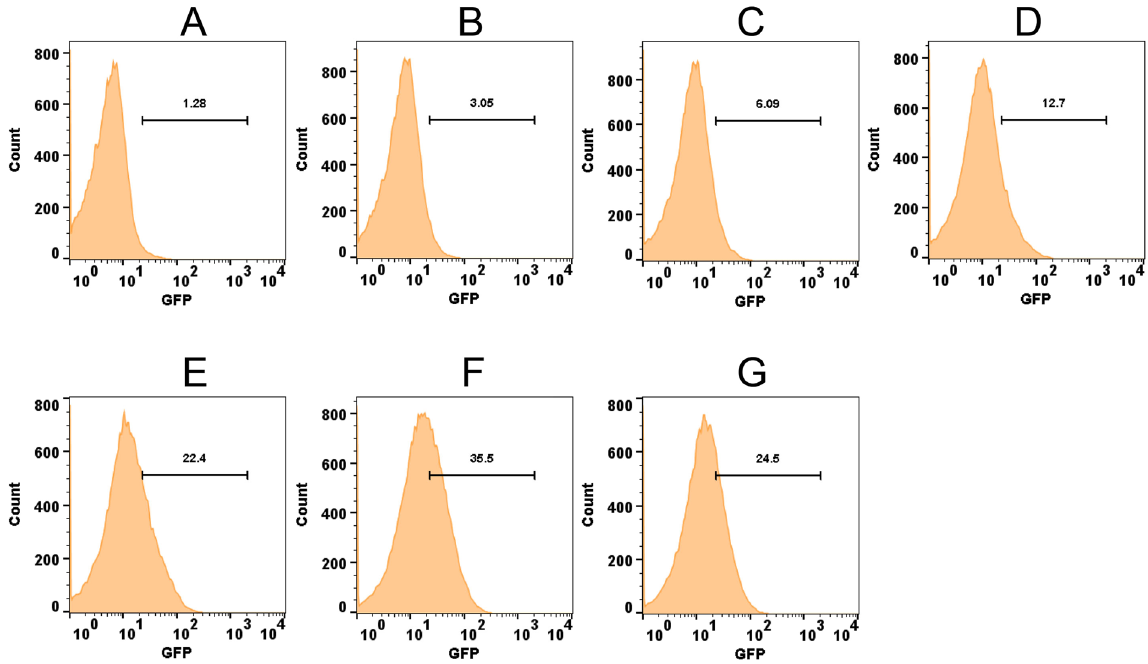
Figure 3. Induction of GFP in M . smegmatis strain MSOHG3 by different concentrations of t -BHP. MSOHG3 carrying ohrR - pohr - gfpuv fusion was treated with different concentrations of t -BHP and incubated at 37 °C for 2 h. Flow analysis was performed in BD FACSAriaII using excitation and emission wavelengths of 395 nm and 509 nm, respectively. ( A ) un-induced control bacteria; ( B–G ) bacteria induced with 25, 50, 100, 250, 500 and 1000 µ M t -BHP, respectively.